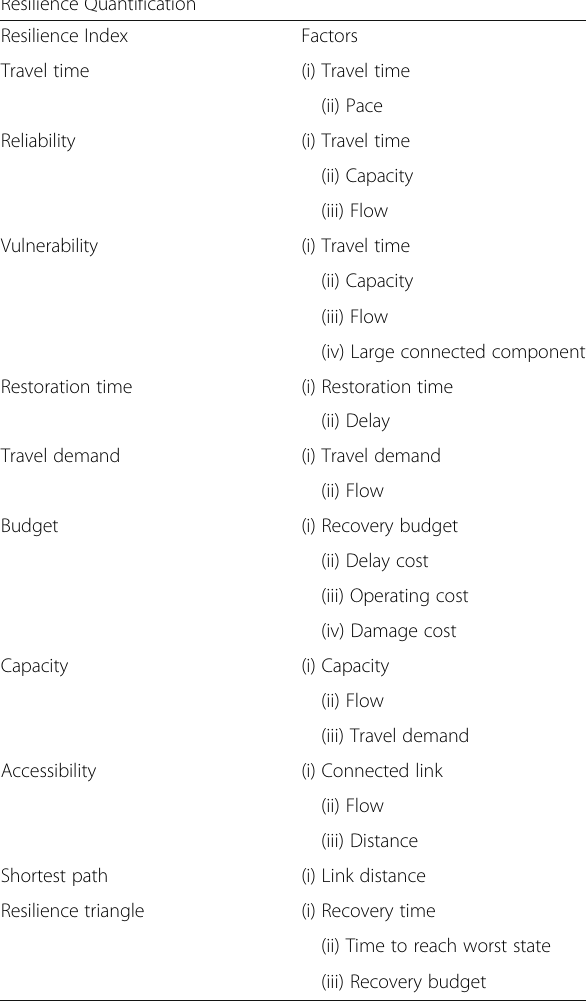
Table 1 Factors considered in the quantification of a